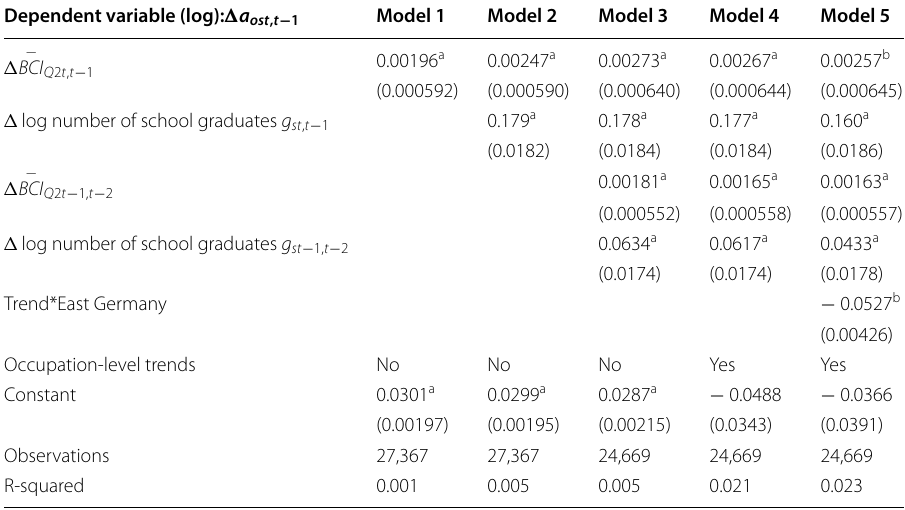
Table 9 First-differences regression (occupation-state-level, apprentices with a high school degree )